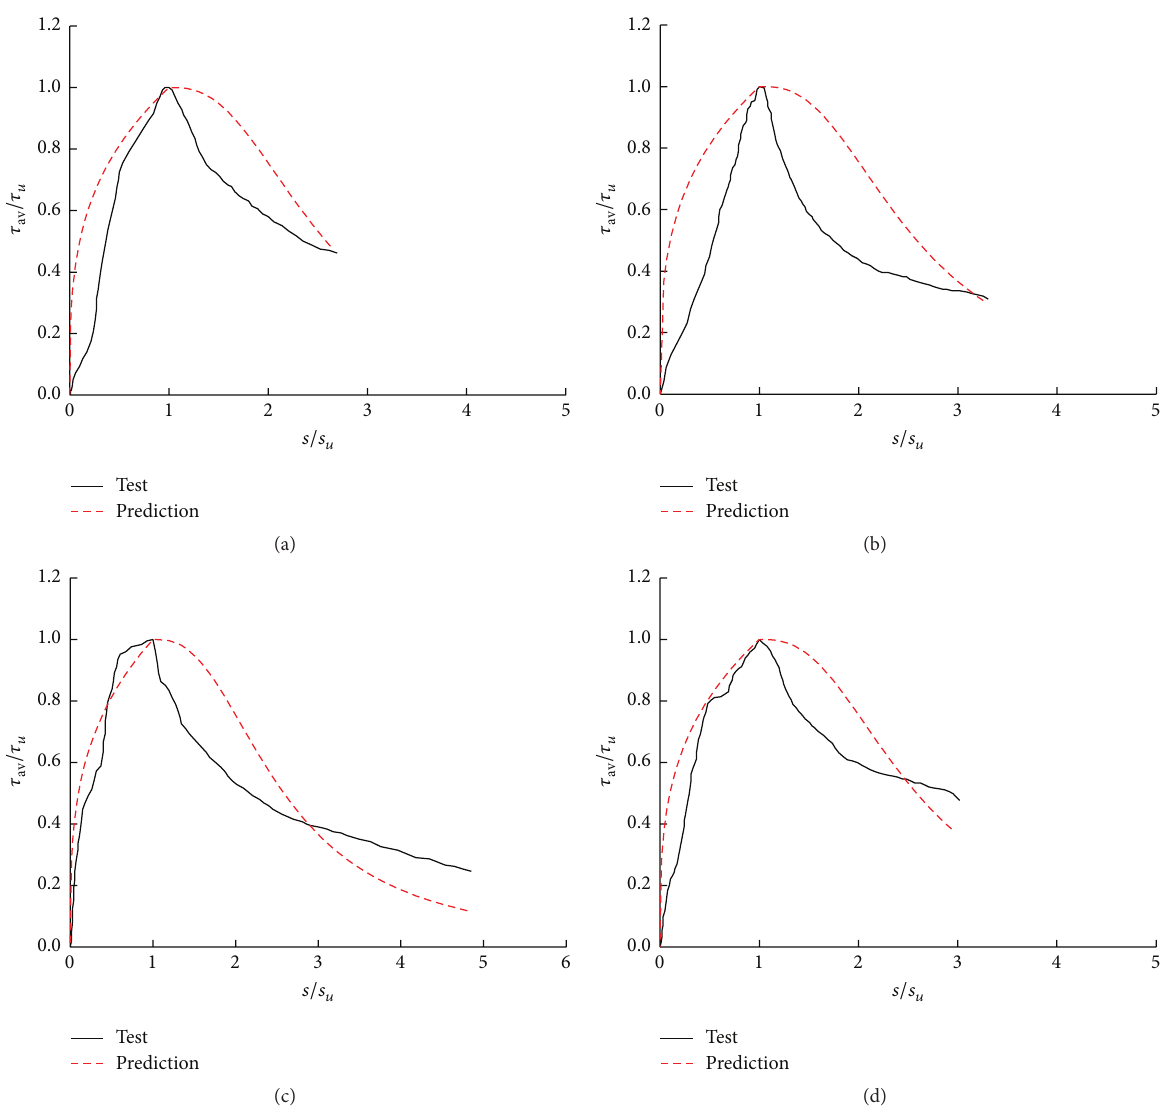
Figure 9: Comparisons of bond-slip curve between test results and predicted results: (a) specimen of PS14-1, (b) specimen of PS14-2, (c) specimen of PS16-1, and (d) specimen of